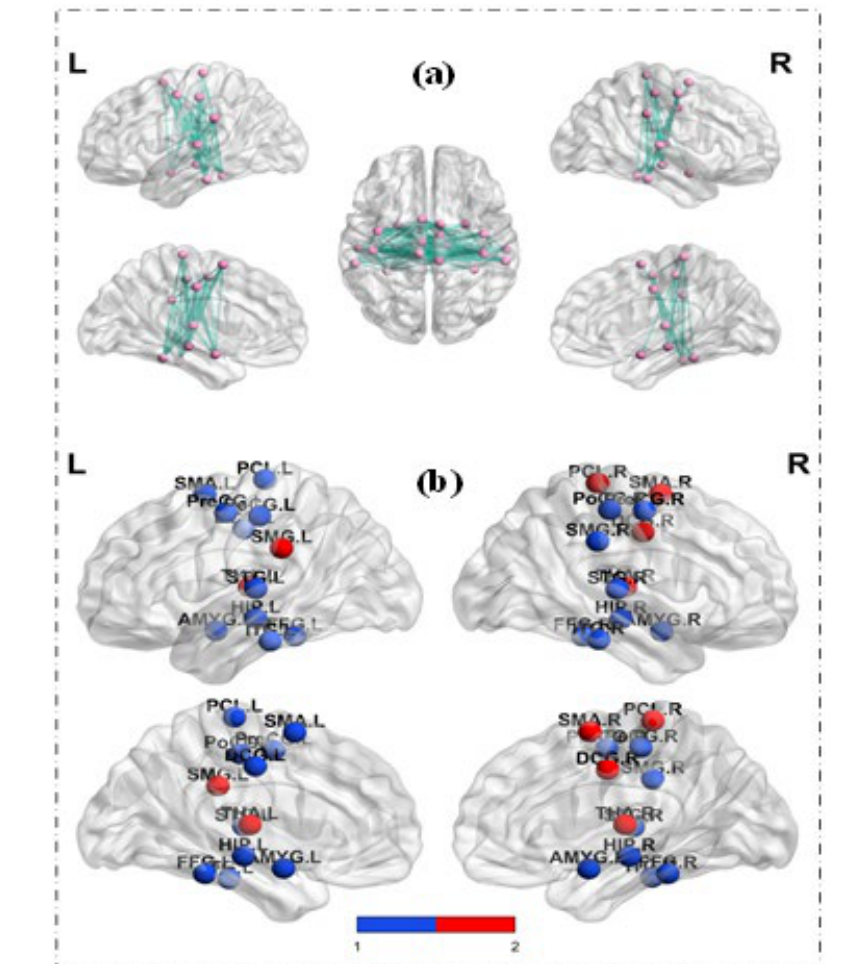
Figure 4. Statistical results of brain networks: ( a ) The results of group comparison analysis of the functional connection of brain networks. ( b ) The results of group comparison analysis of the graph metrics.